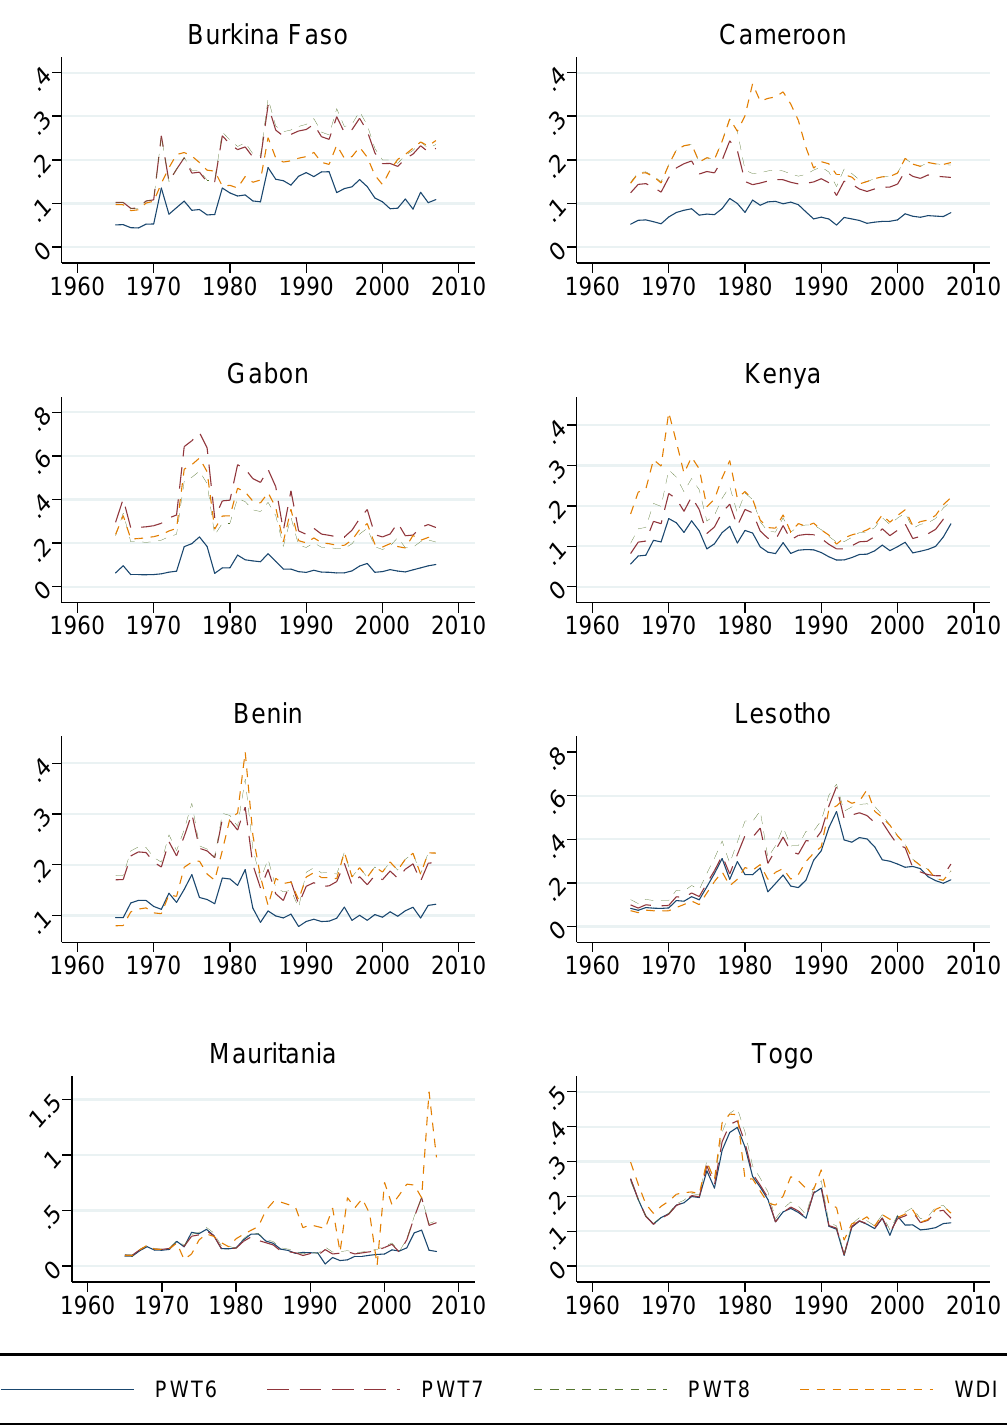
Figure 2: Shares of investment in GDP from four